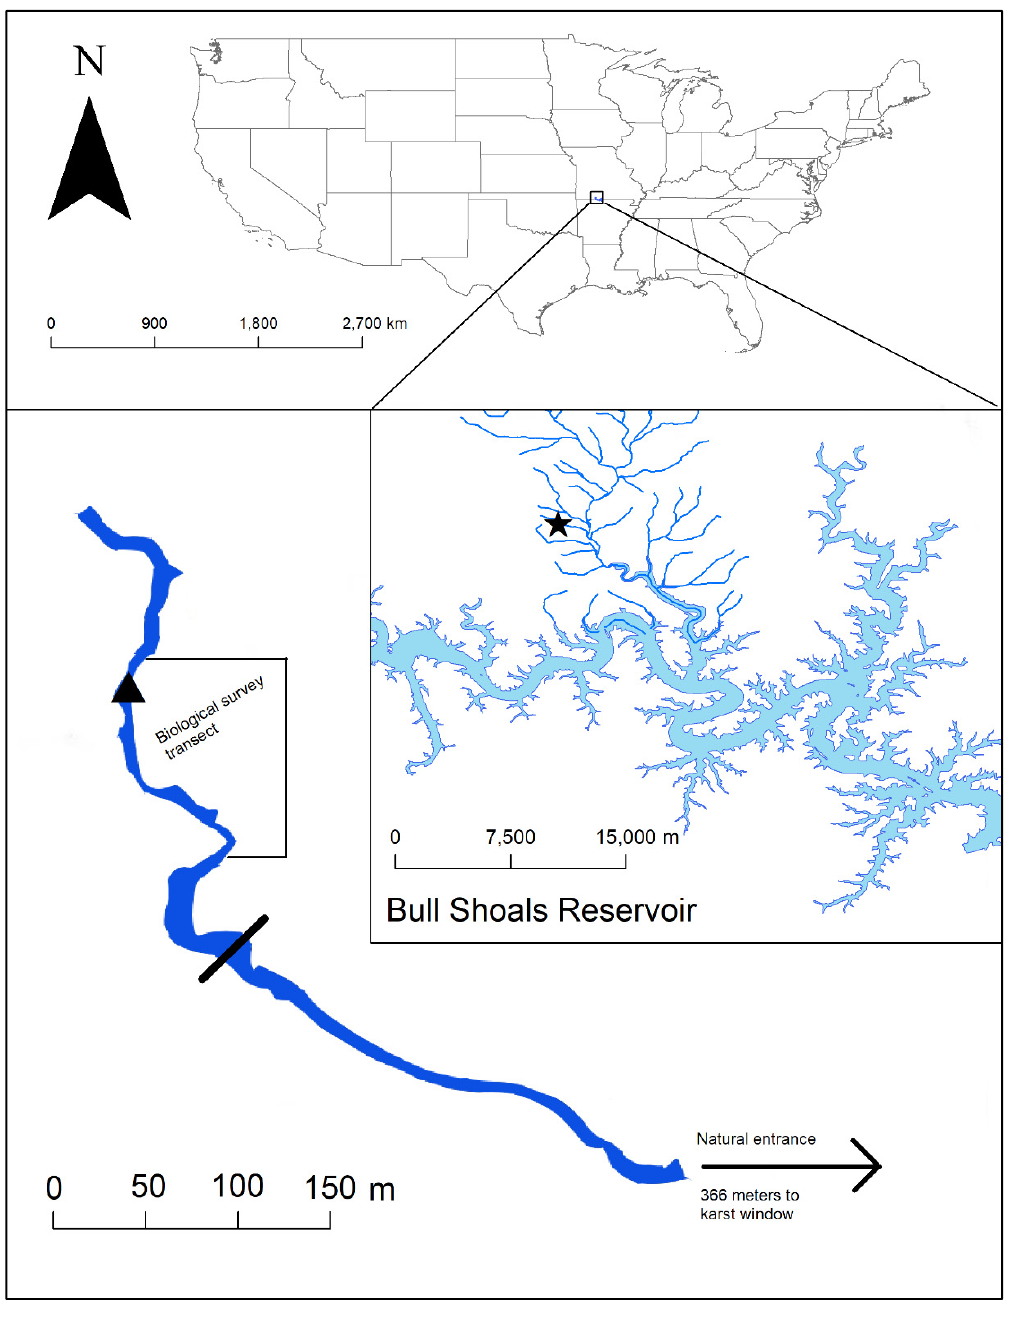
Figure 1. Location of Tumbling Creek Cave in Missouri, USA. The star represents the location of Tumbling Creek Cave at the headwaters of Tumbling Creek of the Ozark Highlands ecoregion. A